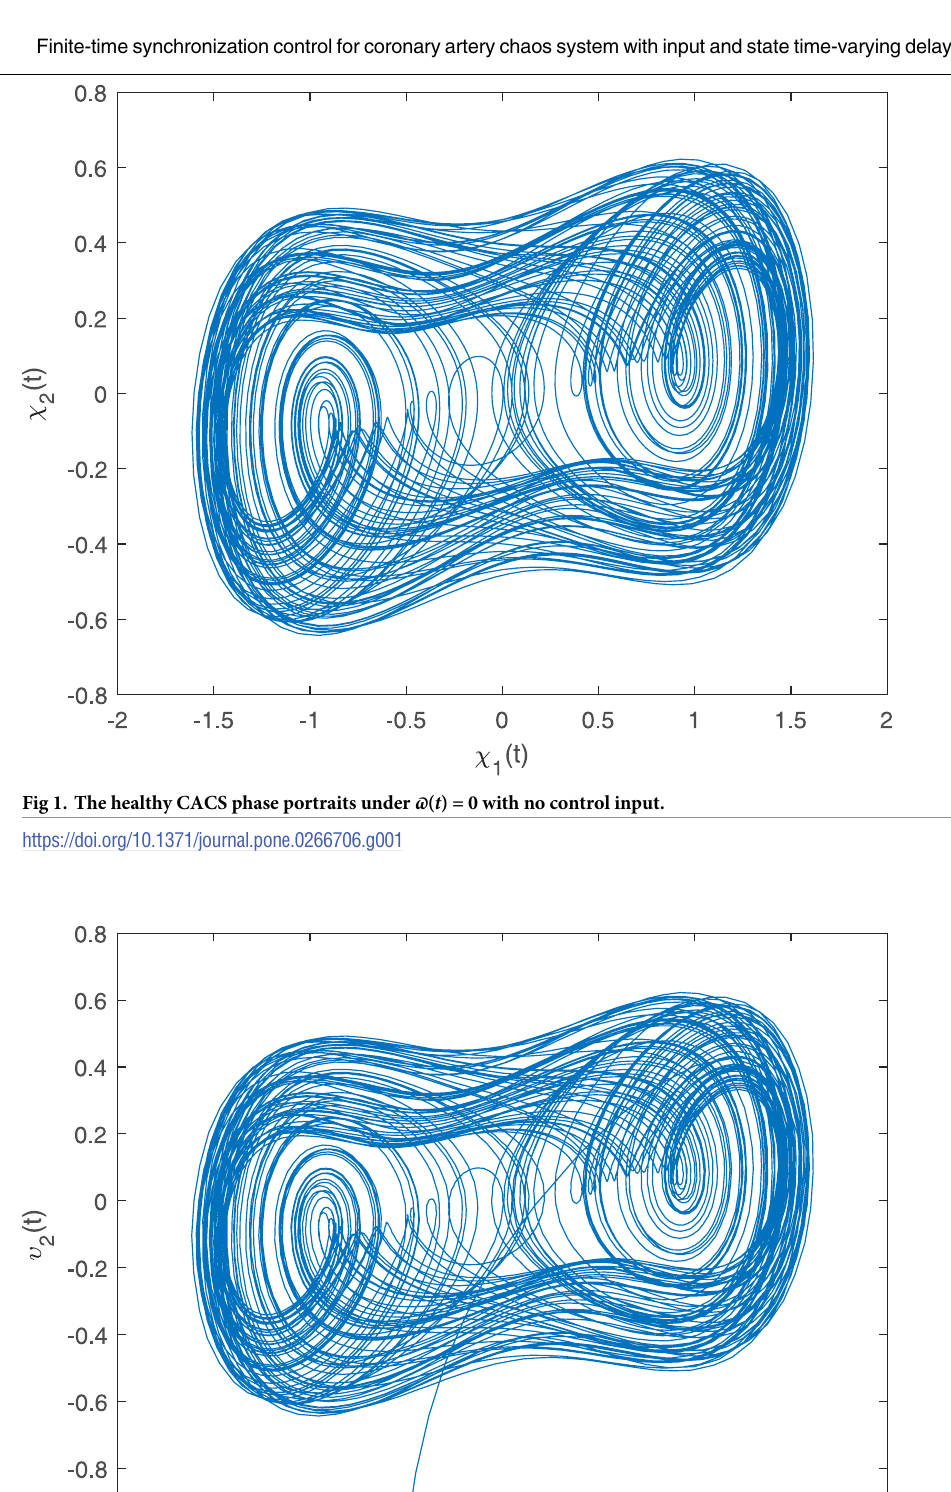
PLOS ONE | https://doi.org/10.1371/journal.pone.0266706 April 8,